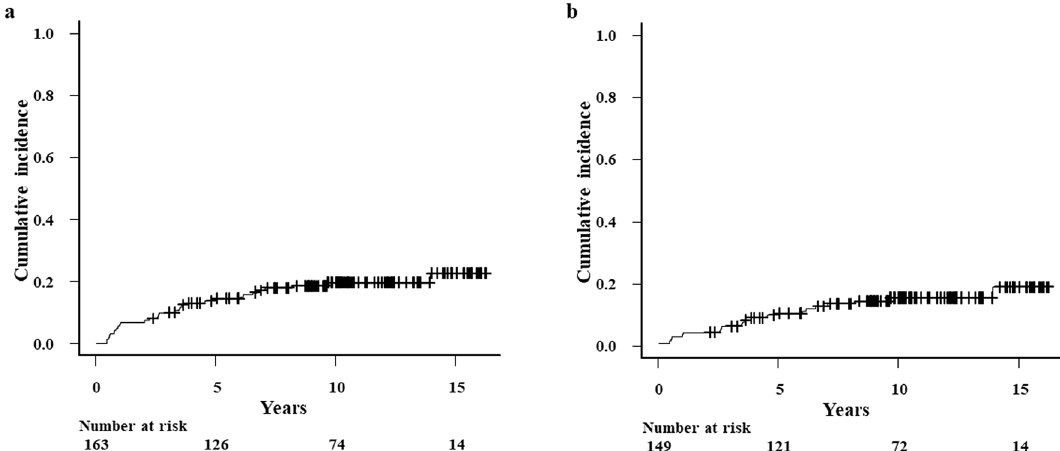
Figure 3. Cumulative incidence of restrictive lung function impairment. ( a ) Patients including those with interstitial disease/organizing pneumonia. ( b ) Patients excluding those with interstitial disease/organizing